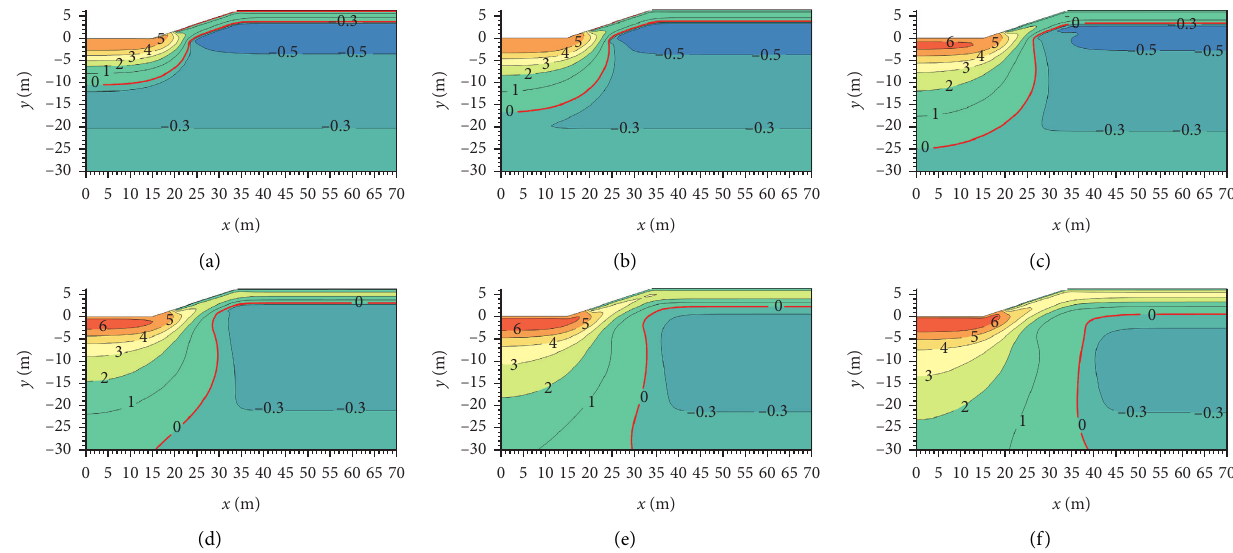
Figure 4: Thermal regimes of subgrade beneath the channel on October 15 after 5 (a), 10 (b), 20 (c), 30 (d), 40 (e), and 50 (f) years of the channel excavation (unit: °